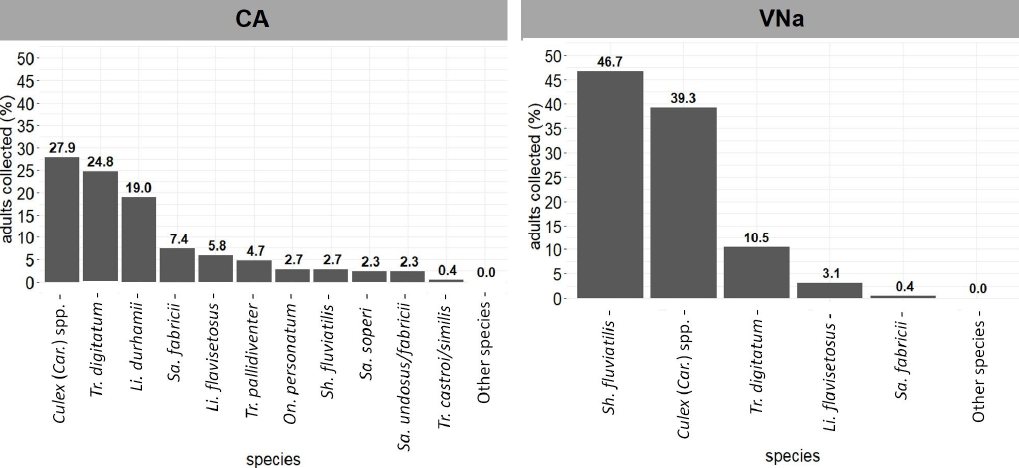
Figure 5. Mosquito species (in decreasing order of abundance) found in immature sampling in Cariacica (CA) and Venda Nova do Imigrante (VNa), Espírito Santo, from April to June 2017.